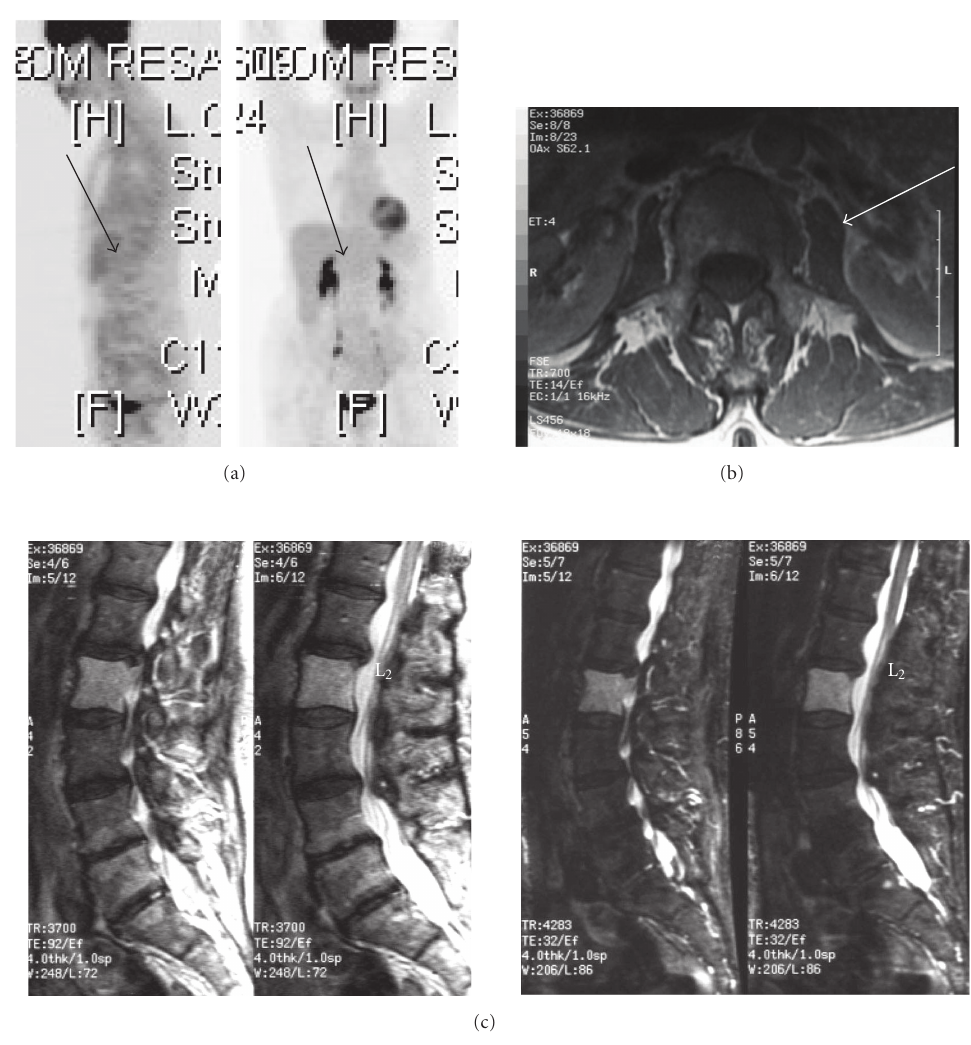
Figure 1: (a) The PET scan did not demonstrate increased glucose uptake in the lumbar spine. (b) and (c) Axial and sagittal MRI demon- srated abnormal signal intensity in the second lumber